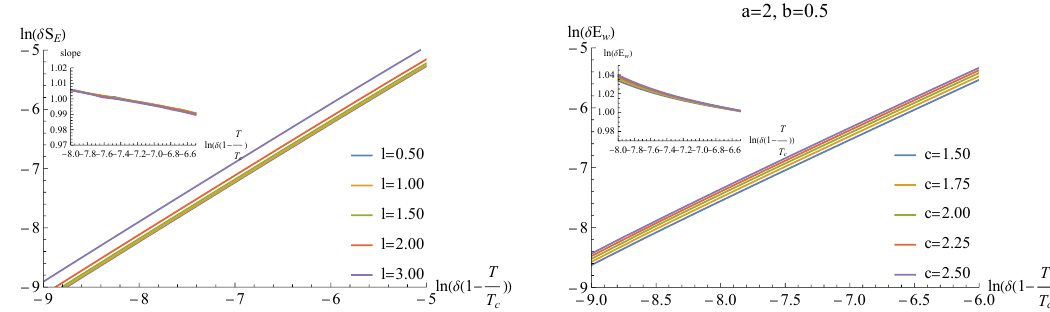
Figure 14 . The scaling behavior of HEE and EWCS. The inset plot shows the slope of the holographic quantum information. Left plot: ln ( δS E ) versus ln ( δ (1 − T l . Right plot: we set a = 2 and b = 0 . 5 and ln ( δE w ) versus ln ( δ (1 − T